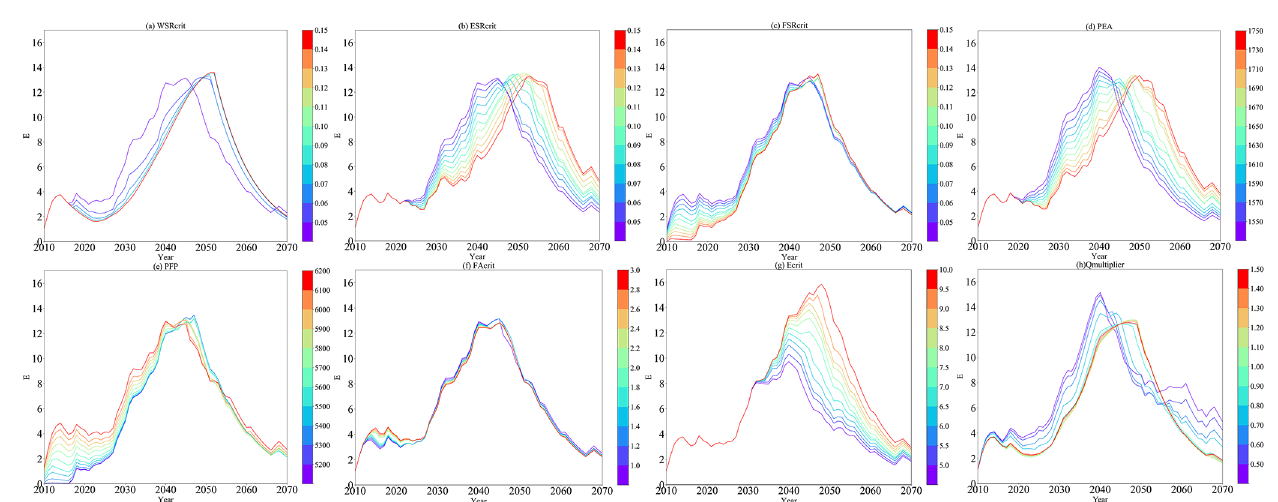
Figure 8. Trajectories of environmental awareness with varied parameters.